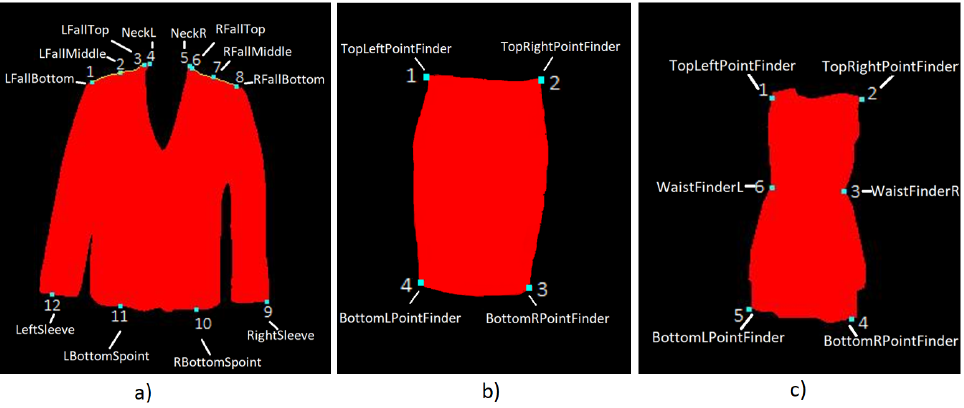
Figure 2. The basic key points of measurements for different type of garment: ( a ) blazer with 12 key points, ( b ) skirt with 4 key points and ( c ) dress with 6 key